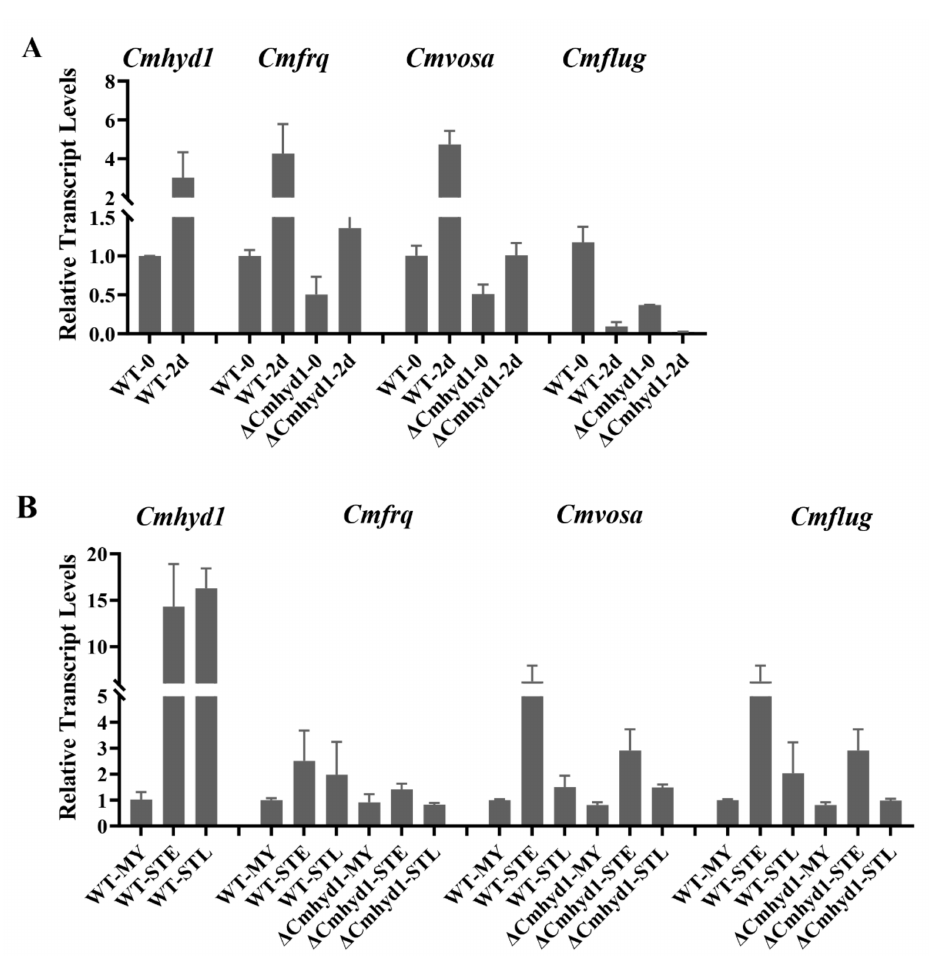
Figure 5. Transcript analysis of Cmhyd1 and conidiation-related genes in ∆ Cmhyd1 and WT strains during conidiation and infection. ( A ) Transcript levels of Cmhyd1 and conidiation-related genes after being exposed to light for 2 d. All results were based on the standard levels of darkness in WT strain. WT-0 and ∆ Cmhyd1-0 indicated the WT and ∆ Cmhyd1 strains cultured in darkness, WT-2 and ∆ Cmhyd1-2 indicate they were exposed to light for 2 d. ( B ) Transcript levels of Cmhyd1 and conidiation-related genes at different infection stages. All results were based on standard levels of mycelial stage in WT strain. MY, STE and STL indicate the stages of mycelia, early sclerotia and late sclerotia, as shown in Figure 4B. Error bars indicate the standard deviation (SD) of three biological replicates with two technical